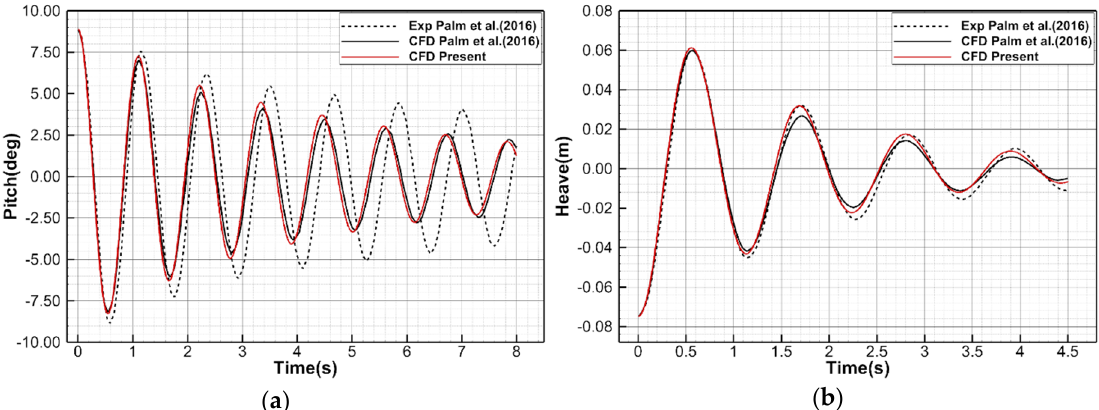
Figure 7. A comparison of the time histories of ( a ) free pitch and ( b ) heave decay curves of a circular cylinder between the present results and those of the reference.